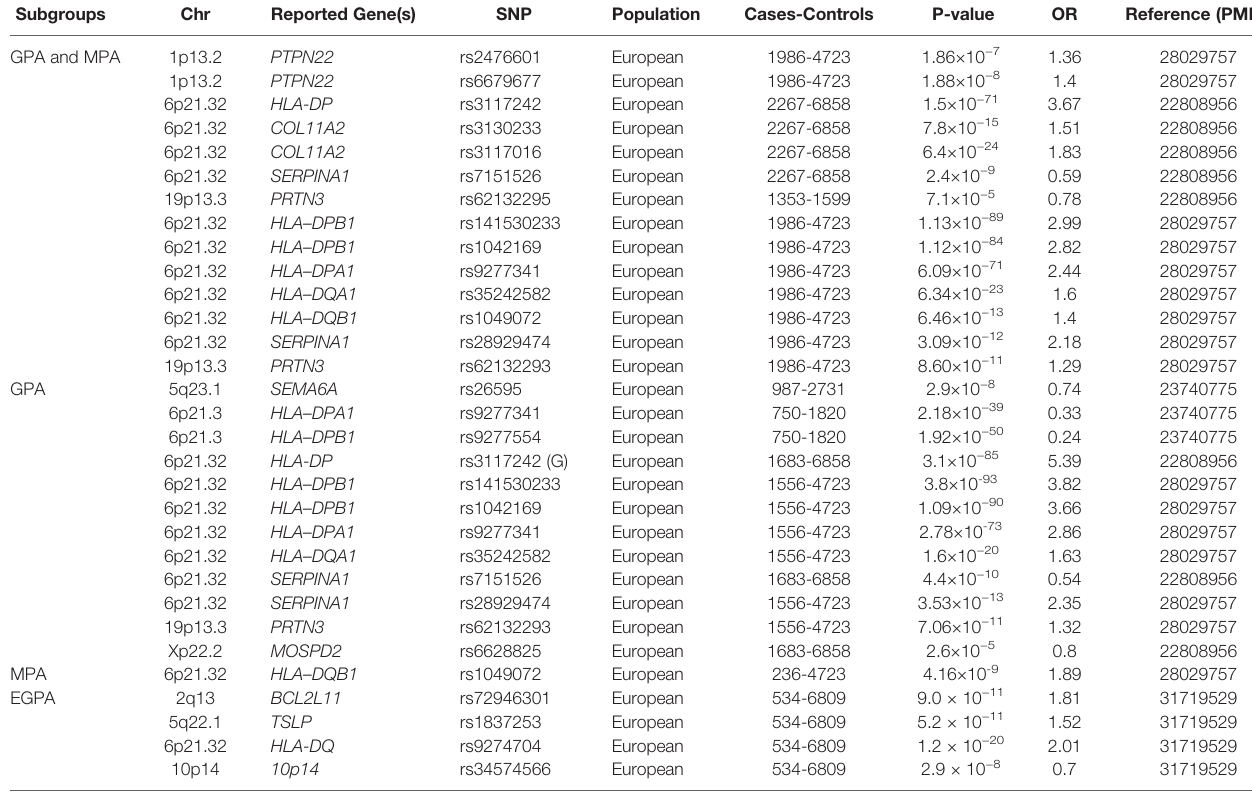
TABLE 1 | A summary of main genetic associations with antineutrophil cytoplasmic antibody (ANCA)-associated vasculitis through genome-wide association studies, according to Clinical subgroups.